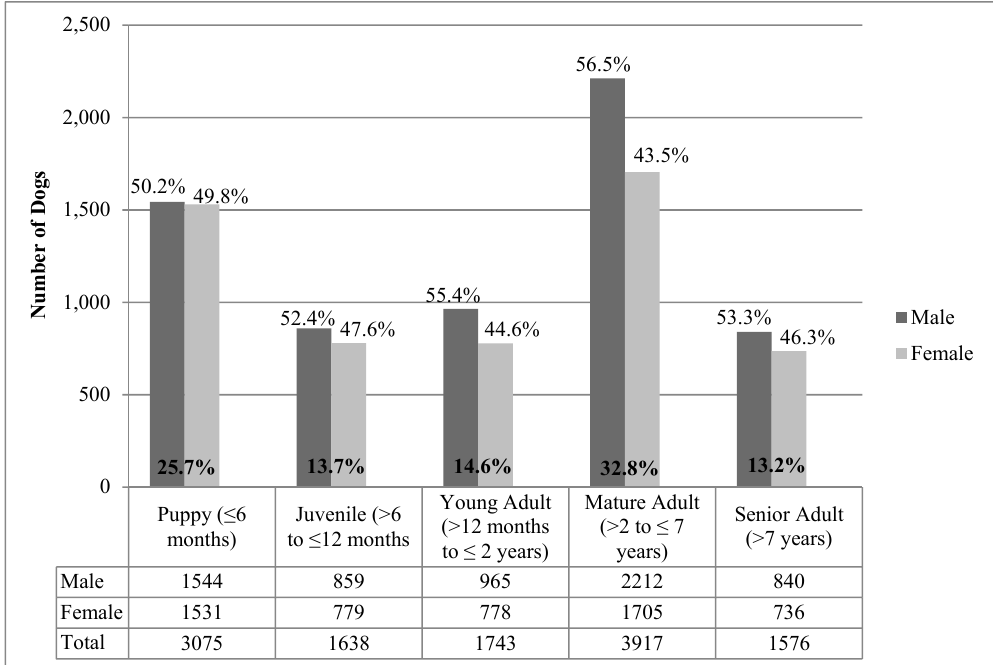
Figure 1 . Summary of age groups and sex for 11,949 dogs admitted to RSPCA Queensland shelters in 2014 (18 dogs were excluded from the analysis because sex was not recorded).